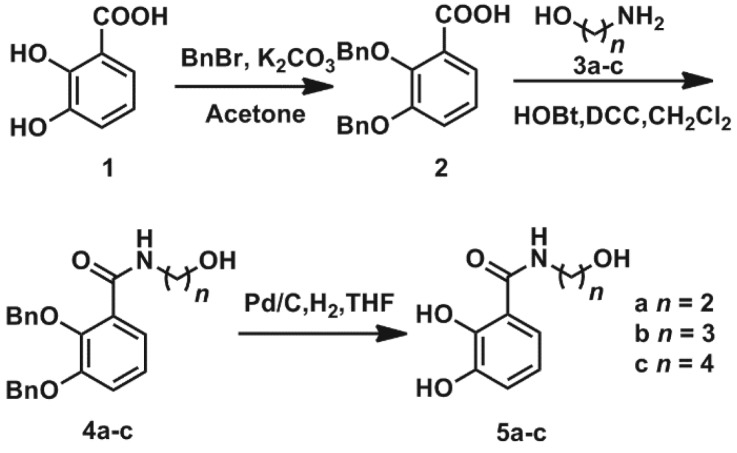
Synthesis of the mono(catecholamine) derivatives 5a–c, L1-3H2.